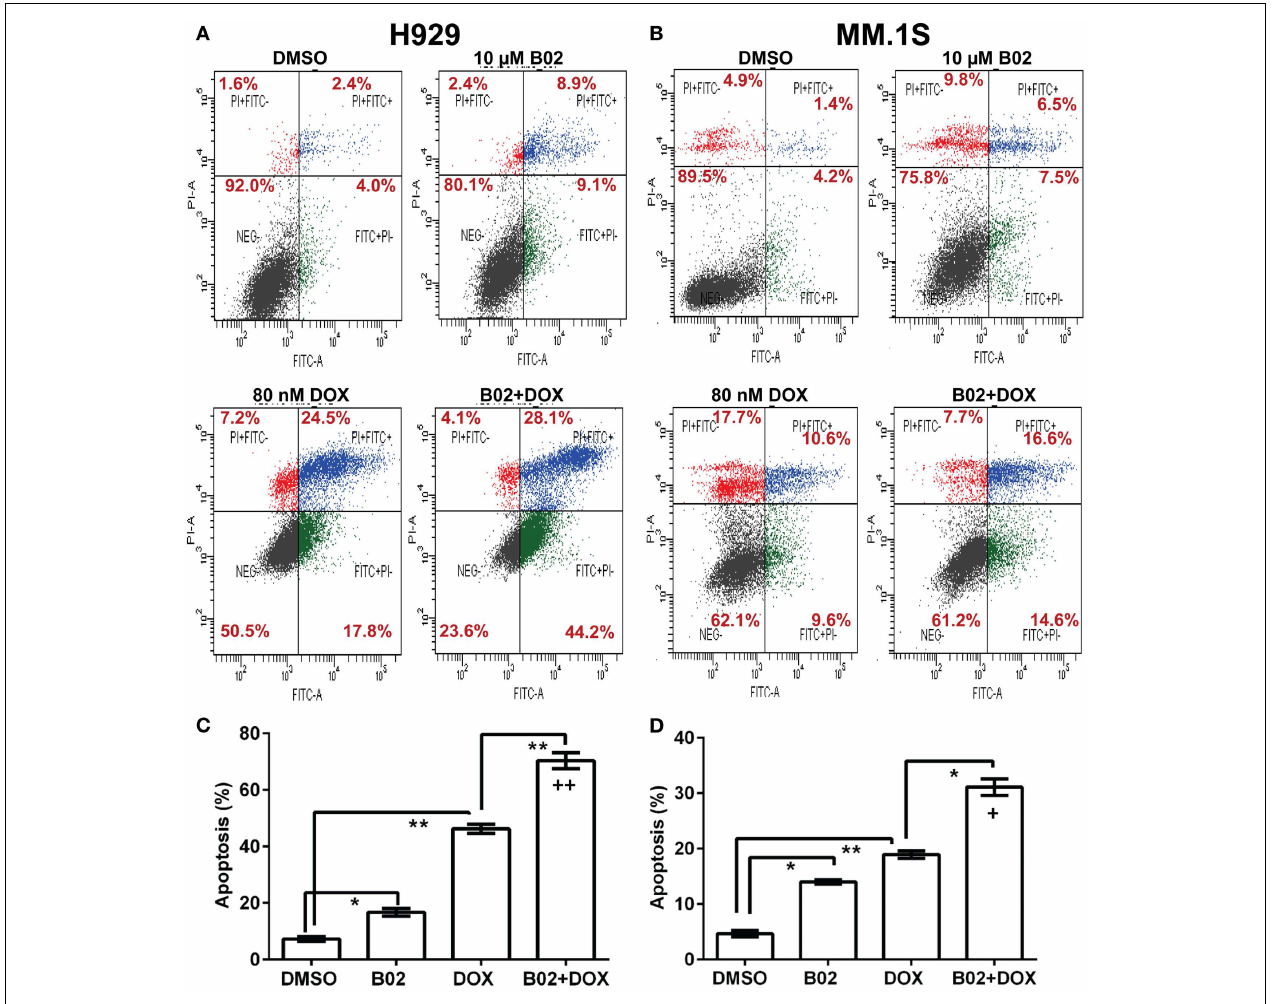
All six replicates of each condition produced similar results. (C,D) Combined data are summarized as the mean ± SEM of six data points from two independent experiments (each with n = 3). *,**Pairs of treatment vs . control groups, connected by brackets, differed significantly (* p < 0.05; ** p < 0.01). +++ , Synthetic lethality was significant ( p < 0.0003), based on a one-tailed heteroscedastic t test comparing the surviving (non-apoptotic) fraction for B02 + DOX combined, vs. the product of the individual surviving fractions after exposure to either agent alone (each corrected for the “background” or uninduced level of apoptosis in cells exposed only to